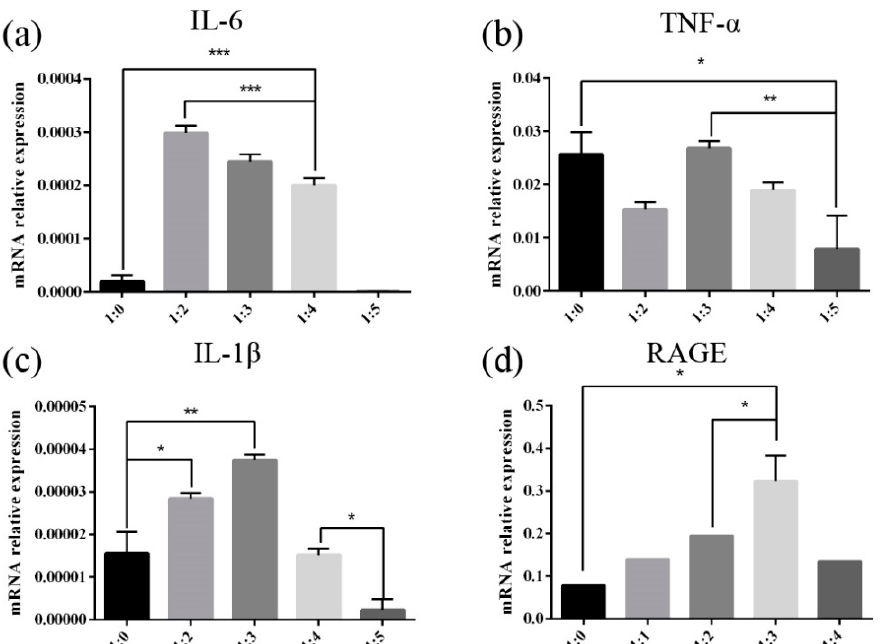
Figure 4. The mRNA expression levels of ( a ) IL-6, ( b ) TNF- α , ( c ) IL-1 β , ( d ) RAGE. The expression levels of IL-6, TNF- α , IL-1 β , and RAGE are detected in the cell supernatant. Data are shown as the mean ± SD. Data are presented as mean ± SEM. Significant differences of IL-6, TNF- α , IL-1 β , RAGE are indicated as * p < 0.05, ** p < 0.01, *** p < 0.001.